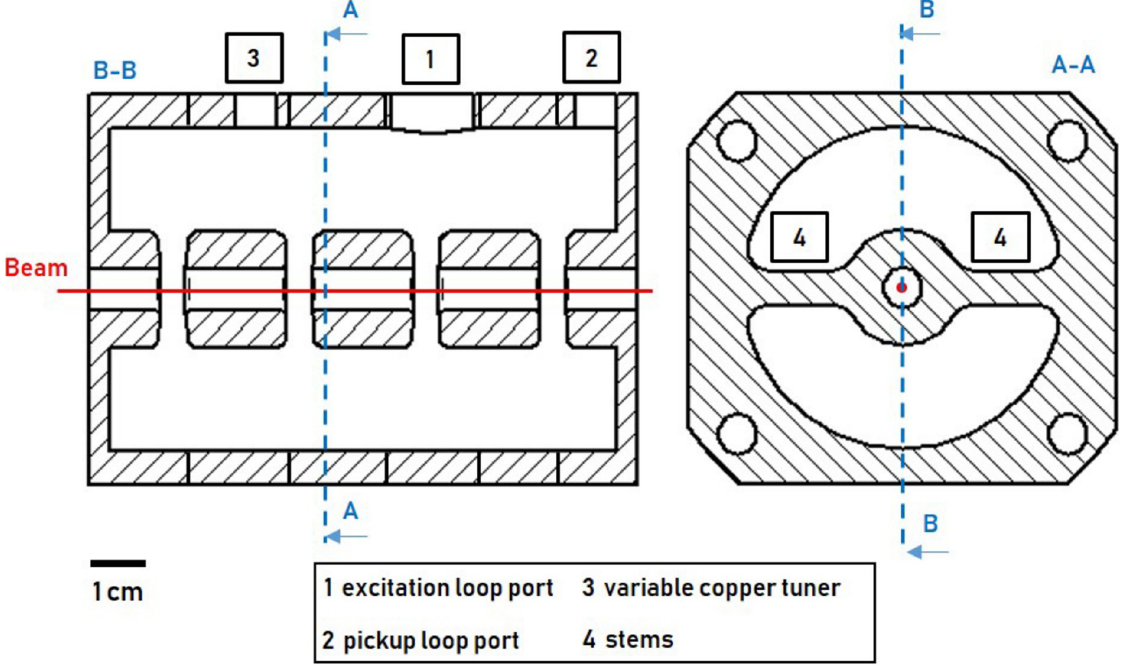
Fig 4. Cavity concept 1 (4-gap): Three drift tubes are attached by stems. Pickup loop, excitation loop and copper tuner have access to the cavity through ports. Red line: proton beam.